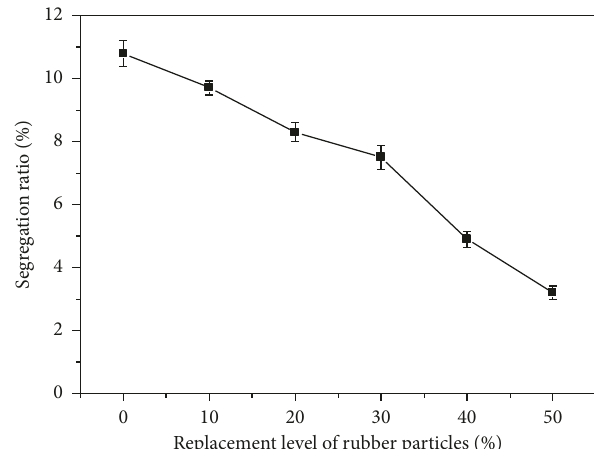
Figure 18: Influence of the replacement level of rubber particles on segregation